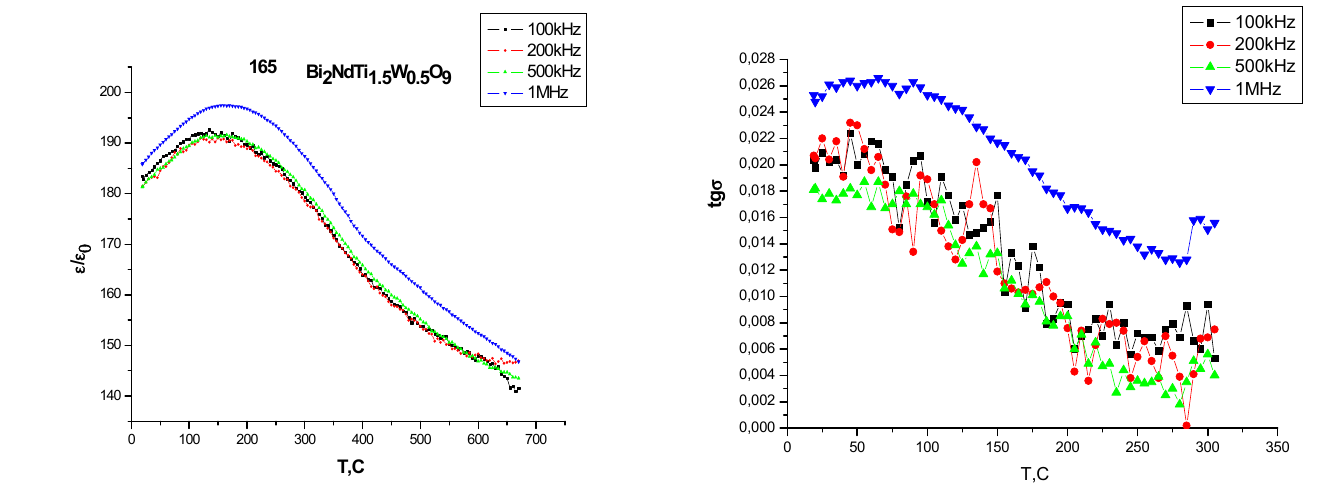
Figure 3. Temperature dependences of the relative permittivity ε / ε 0 and loss tangent t g σ for APs Bi 3 − x Nd x Ti 1.5 W 0.5 O 9 (x = 0.25, 0.5, 0.75, 1.0) at a frequency from 100 kHz to 1 MHz: Bi 2.75 Nd 0.25 Ti 1.5 W 0.5 O 9 , Bi 2.5 Nd 0.5 Ti 1.5 W 0.5 O 9 , Bi 2.25 Nd 0.75 Ti 1.5 W 0.5 O 9 , Bi 2 NdTi 1.5 W 0.5 O 9 . For Bi 3 − x Nd x Ti 1.5 W 0.5 O 9 (x = 0.25, 0.5, 0.75), the ε ( T ) dependences are clearly pro-